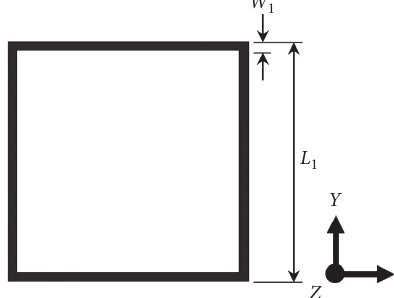
Figure 4: The initial CMA-based square loop